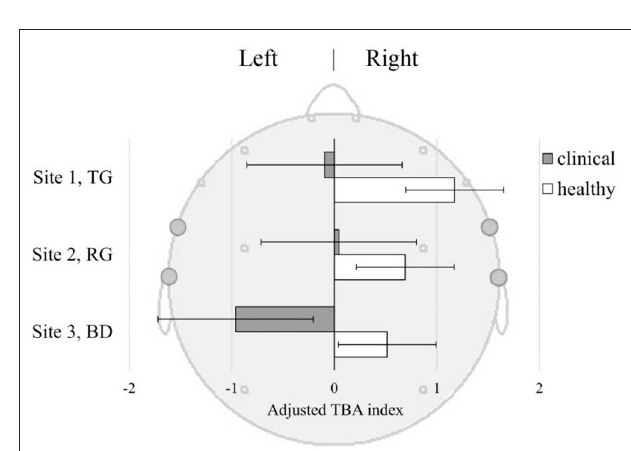
FIGURE 5 | Frontal Alpha Asymmetry (FAA) index ± SE, in Clinical and Healthy samples at three sites: TG, Therapeutic Garden; RG, Residential Green; BD, Busy Downtown. FAA index [(R-L)/(R + L)] was derived from baseline-corrected power density values from the left (AFp1 + AFF6h + F7) and right (AFp2 + AFF6h + F8) frontal lobes.